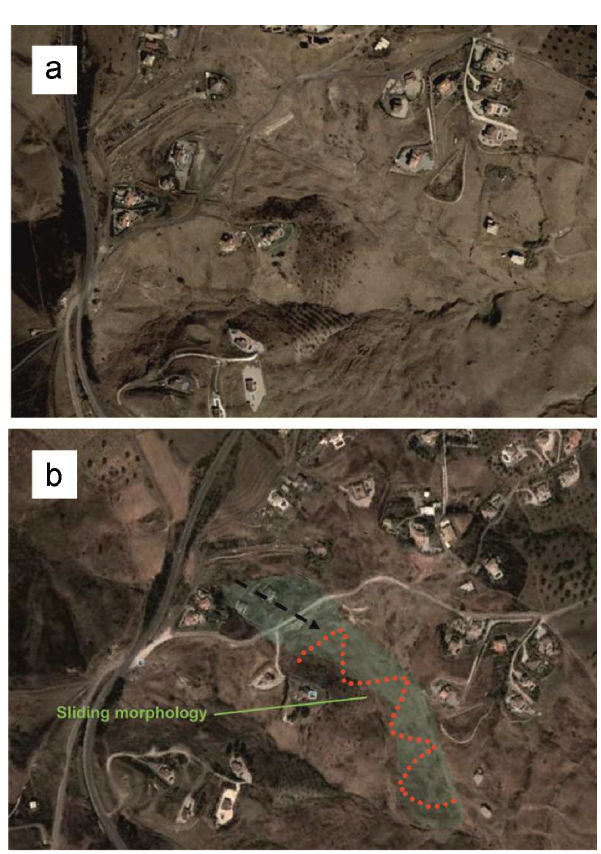
Figure 8. (a) Topographic map in a GIS map from page num- ber 1039 of the IGN (Spanish National Geographic